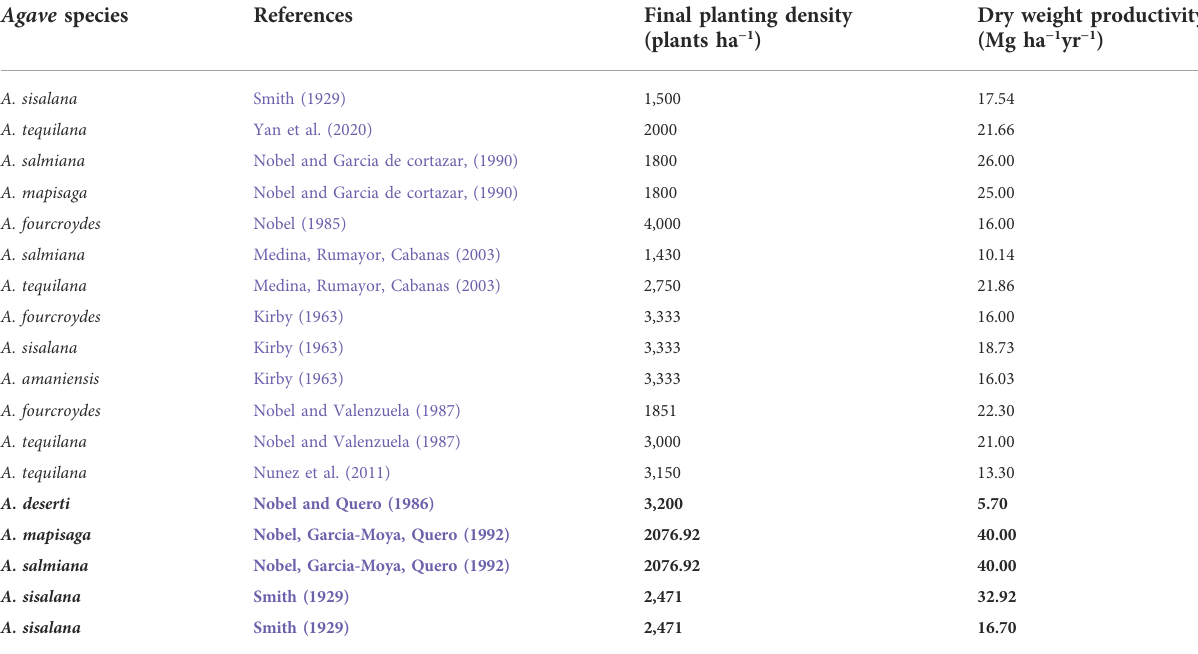
TABLE 2 Dataset used in the meta-analysis. The results in bold were not used in the fi nal meta-analysis. The table is in order of planting density. Agave species